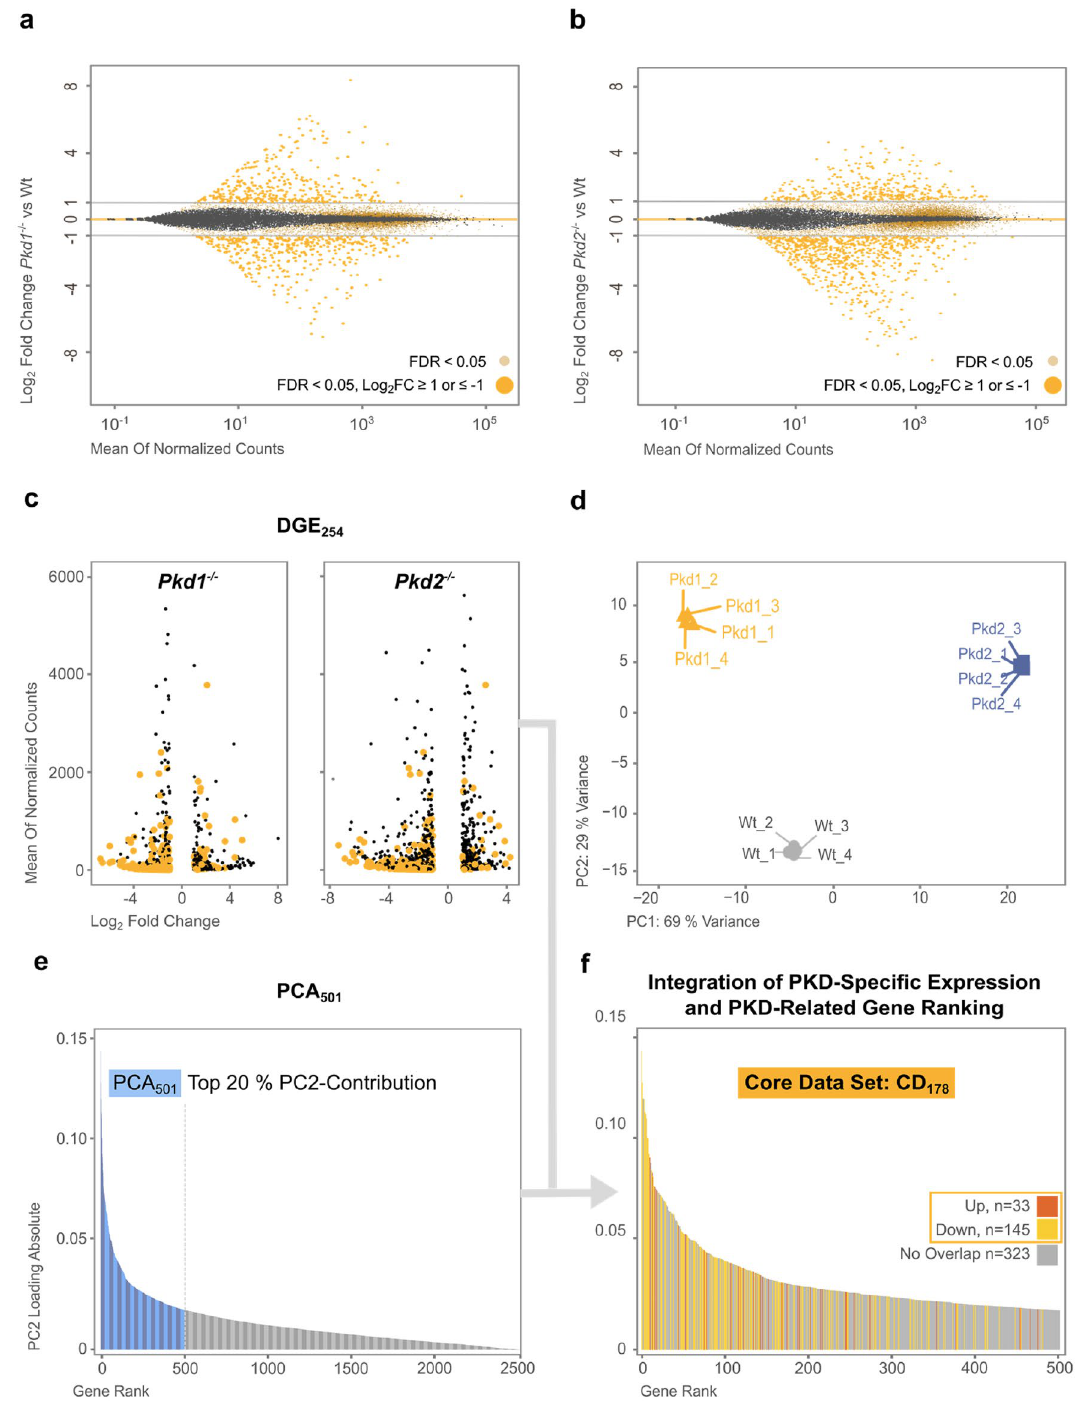
Figure 3. Complementary mathematical analysis of Pkd1- and Pkd2-responsive transcripts identified a core ADPKD data set of 178 consistently regulated genes (CD 178 ). To identify genes involved in ADPKD pathogenesis, two independent mathematical approaches were used: (1) statistical analysis of differential gene expression (DGE); and (2) unbiased data simplification by principal component analysis (PCA). ( a ) and ( b ) Applying RNA-seq on Pkd1- and Pkd2-deficient mIMCD3 cells revealed a total of 791 differentially expressed genes in Pkd1 −/− and 1250 in Pkd2 −/− cells (large, dark-yellow dots: FDR < 0.05, log 2 fold change ≥|1|). In Pkd1 −/− cells, > 54% (429 genes) and in Pkd2 −/− cells, > 63% (790 genes) were downregulated. ( c ) Filtering DGE of Pkd1 −/− and Pkd2 −/− for concordant changes provided 254 genes (DGE 254 ), of which 38 were up- and 216 downregulated genes (orange dots). ( d ) 10% most variant genes were input for PCA (n = 2,506, with reads obtained for 25,062 genes). Principal component 1 (PC1) mainly accounted for non-Pkd- related differences between wildtype, Pkd1 and Pkd2 cells. PC2 discriminated Pkd1 −/− and Pkd2 −/− from wildtype, accounting for 29% of total variance. ( e ) Since PC2 correlated with Pkd1- and Pkd2-deficiency, genes were ranked according to their PC2 contribution, and the top 20% (n = 501, marked in blue) were selected for further data analysis (PCA 501 ). ( f ) Comparison of DGE 254 and PCA 501 identified 178 candidate genes specifically responding to Pkd1- and Pkd2-deficiency in mIMCD3 cells (core data set; CD 178